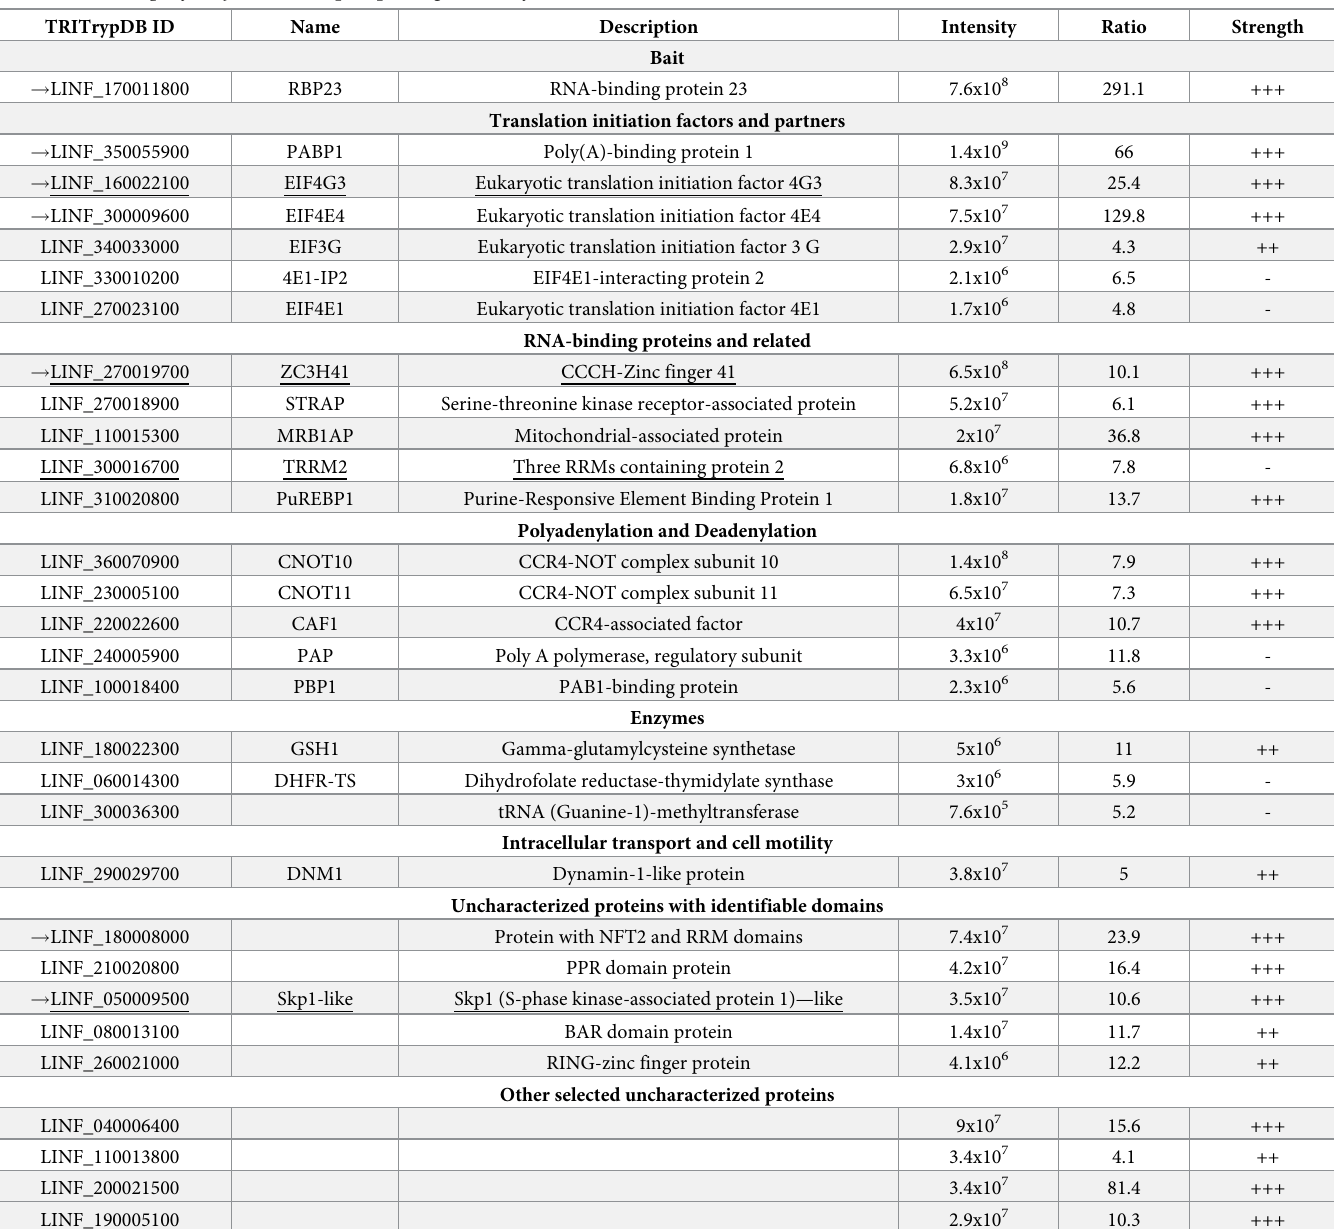
Table 1. Proteins specifically co-immunoprecipitating with L . infantum